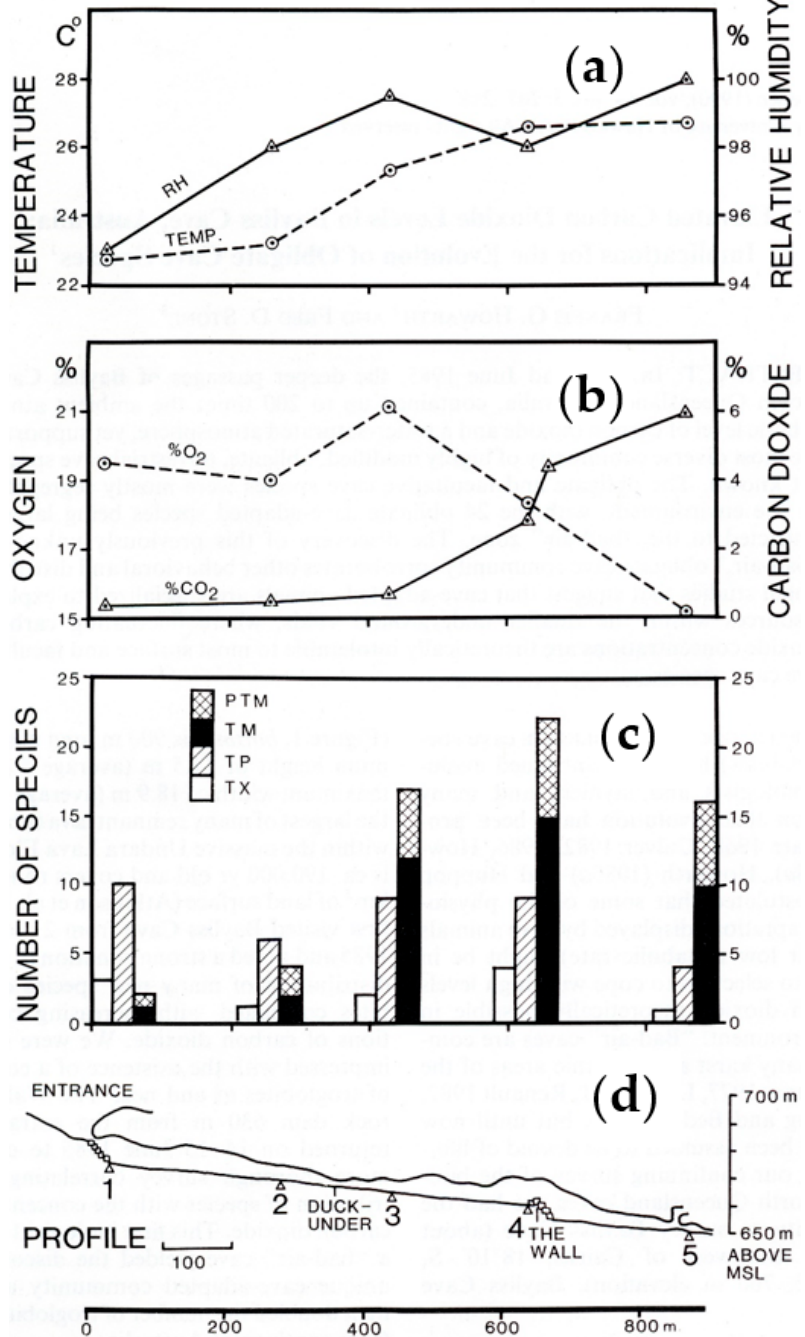
Figure 6. Environment and arthropod distribution in Bayliss Cave plots measured 14–15 June 1985 at progressively greater distances from the entrance: ( a ) temperature and relative humidity; ( b ) oxygen and carbon dioxide; ( c ) abundance of trogloxenes, troglophiles, partially troglomorphic and highly troglomorphic at the numbered positions in ( d ) map profile view with sampling stations numbered: 1—near entrance, 2—before the Duck-Under, 3—beyond the Duck-Under, 4—The Wall, 5—beyond The Wall. After [2], reproduced with author